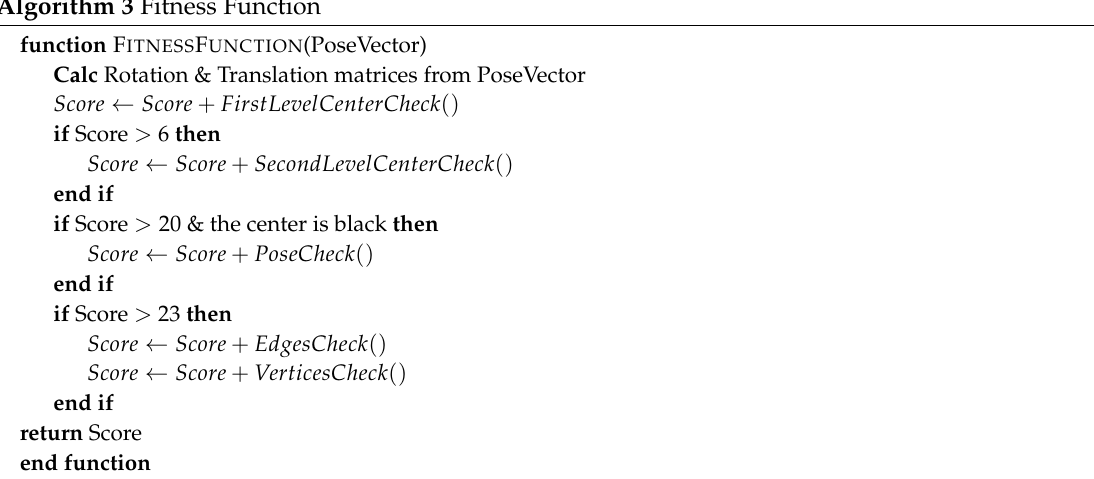
Algorithm 3 Fitness